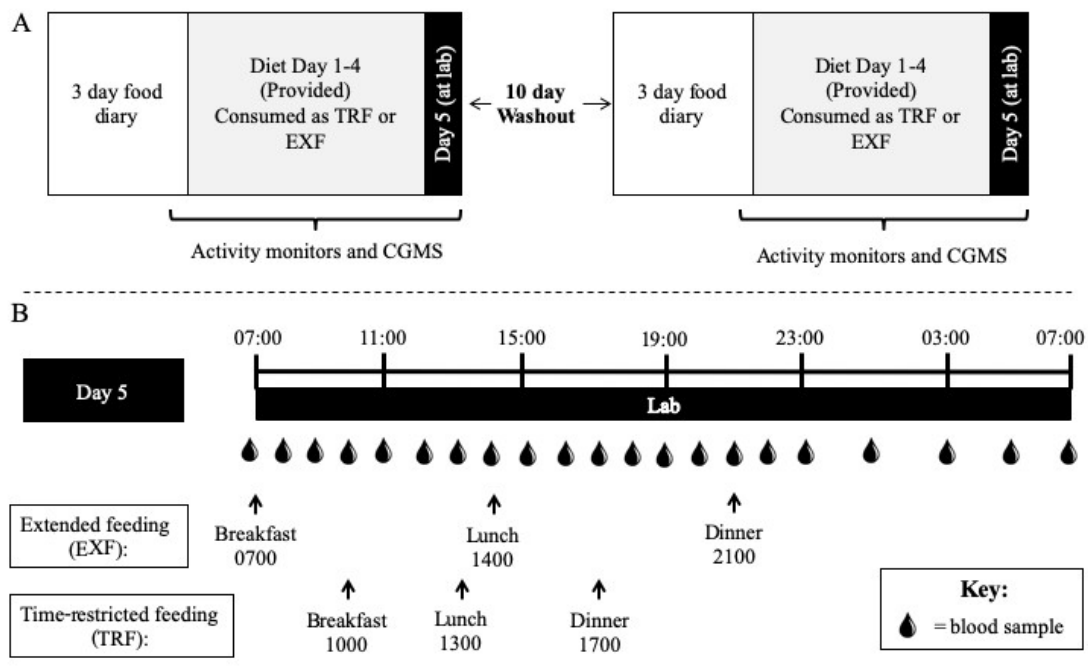
Figure 1. Study design schematic. Participants visited the laboratory at Day 0 to have activity monitors attached, continuous glucose monitoring system (CGMS) inserted and pick up Days 1–4 of the diet (50% total energy intake (TEI) fat, 30% TEI carbohydrate and 20% TEI protein) to be consumed in a time-restricted feeding (TRF) (1000, 1300 and 1700 h) or extended feeding (EXF; 0700, 1400 and 2100 h) pattern, in a randomized order separated by a 10 day washout period ( A ), before returning at 0645 h on Day 5 for a 24-h laboratory trial ( B ) .